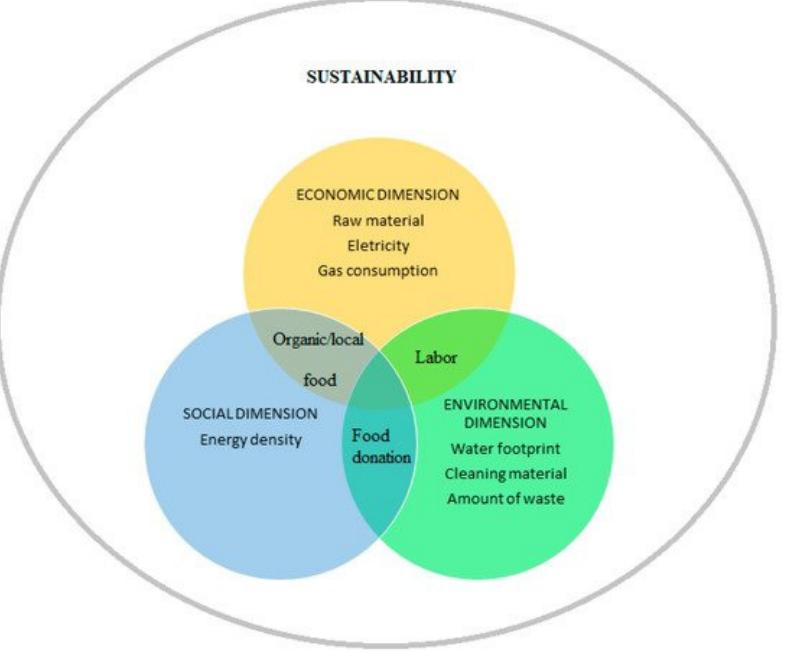
Figure 1. Impacts of food waste in foodservice [13]